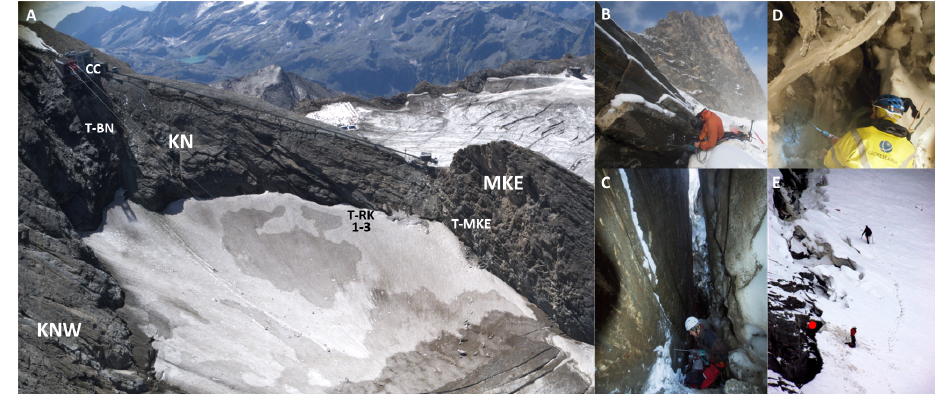
Figure 5. Deep and shallow borehole temperature monitoring at Kitzsteinhorn: (a) air photo (photo: Robert Delleske, 24 August 2017); (b) measurement site at the randkluft aperture (T-RK1) (photo: Ingo Hartmeyer: 4 September 2015); (c) measurement site inside the randkluft, 7m below the 2015 glacier surface (T-RK2) (photo: Robert Delleske, 4 September 2015); (d) measurement site inside the randkluft, 14m below glacier surface (T-RK3) (photo: Markus Dörfler, 21 September 2018); (e) view of the investigated randkluft from the cable car top station (CC); red dot indicates position of T-RK1 (photo: Floreana Miesen, 4 September 2015).